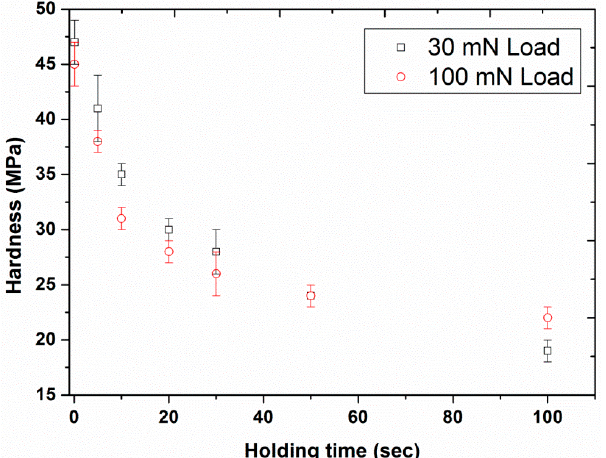
Figure 16. Hardness as a function of holding time for the two different peak loads, 30 and 100 mN with loading time of 10 s. Bars represent standard deviations. Polymers 2020 , 12 , x FOR PEER REVIEW